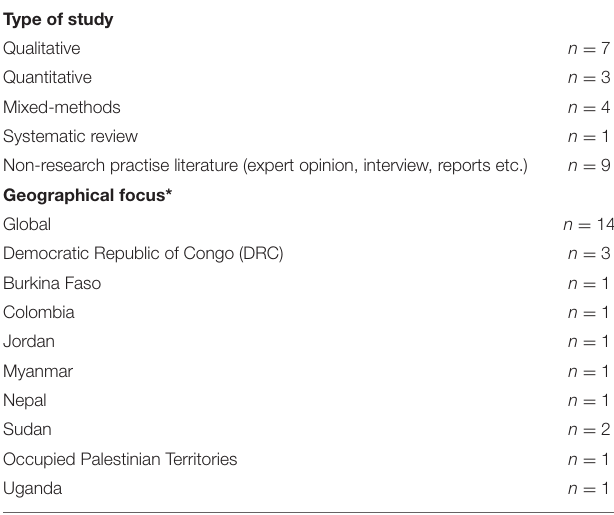
TABLE 2 | Included article